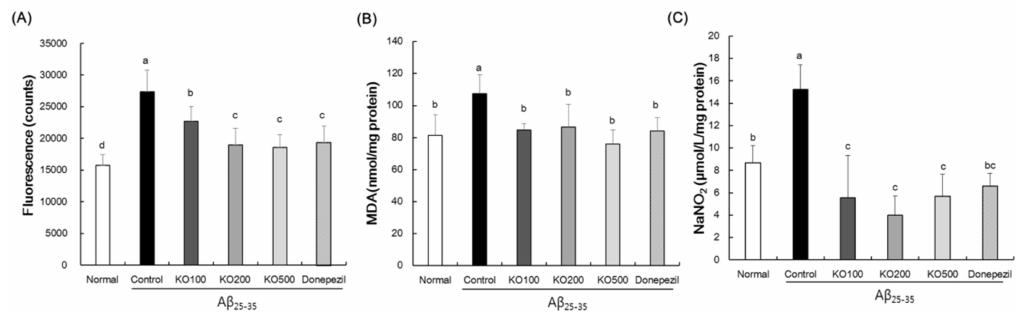
Figure 1. E ff ects of krill oil (KO) on oxidative stress-related factors such as reactive oxygen species ( A ), lipid peroxidation ( B ), and nitric oxide ( C ) in the brain. Normal, injection of saline solution + oral administration of water; Control, injection of A β 25–35 + oral administration of water; KO100, injection of A β 25–35 + oral administration of KO at 100 mg / kg / day; KO200, injection of A β 25–35 + oral administration of KO at 200 mg / kg / day; KO500, injection of A β 25–35 + oral administration of KO at 500 mg / kg / day; Donepezil, injection of A β 25–35 + oral administration of donepezil at 5 mg / kg / day. Values are represented as means ± SD ( n = 8). a–d Means with the di ff erent letters are significantly di ff erent ( p < 0.05) by Duncan’s multiple range test. b,c Means with the same letter such as b and c are not significantly di ff erent ( p < 0.05) by Duncan’s multiple range